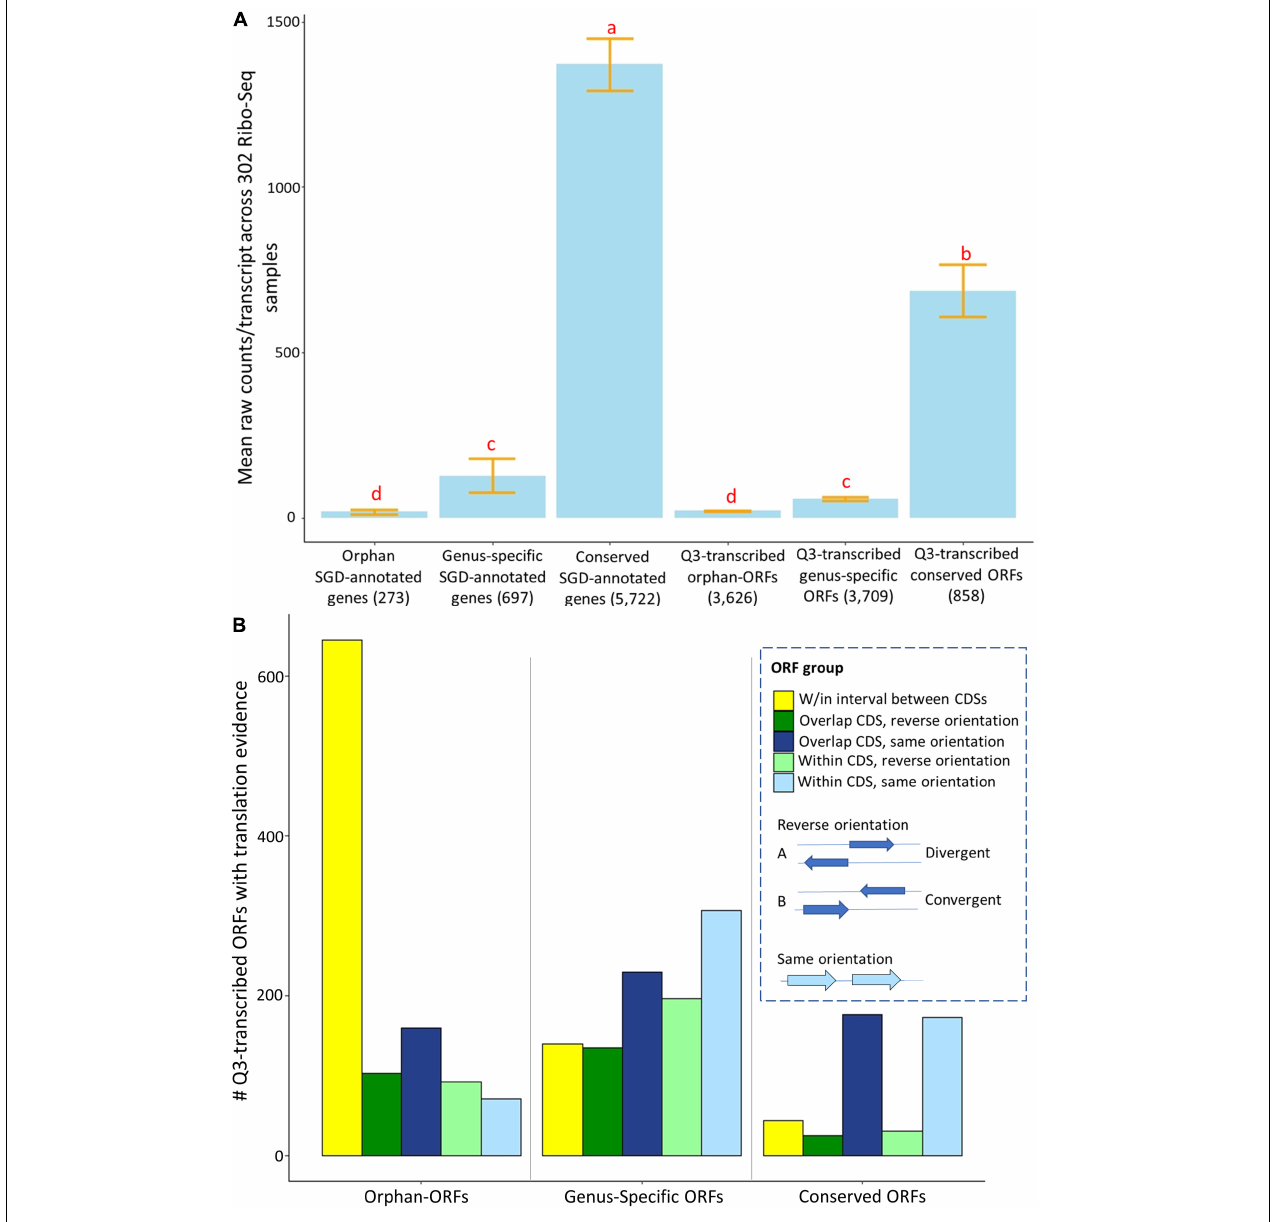
FIGURE 5 | Mean expression and numbers of genes and ORFs with translational evidence, partitioned by phylostrata and genomic context. Ribo-Seq data were analyzed for genes and ORFs across 302 samples using ribotricer (Choudhary et al., 2019). (A) Mean raw Ribo-Seq counts per transcript for all genes and ORFs. X -axis, genes and ORFs as classified by phylostrata. Y -axis, mean value of raw read counts. The letters above each bar indicate significance in each group according to a t -test ( p -value cutoff is 0.01). Similar to mean RNA-Seq counts, the conserved genes and conserved-ORFs have more total mean Ribo-Seq counts. (B) . The 3,857 Q3-transcribed ORFs that had Ribo-Seq translation evidence were divided into groups according to their relationship to annotated, and the numbers of genes and ORFs with translational evidence was determined. The gene/ORF with mean counts across 302 Ribo-Seq samples higher than 1.83 was consider to have translation evidence. X -axis, groups of genes and ORFs, classified by phylostrata. Y -axis, number of ORFs in each group. The proportions of ORFs are significantly different among three phylostratal groups according to a chi-square test ( p -value < 0.001). Over 60% the orphan-ORFs with translation evidence are located in the interval between protein coding sequences